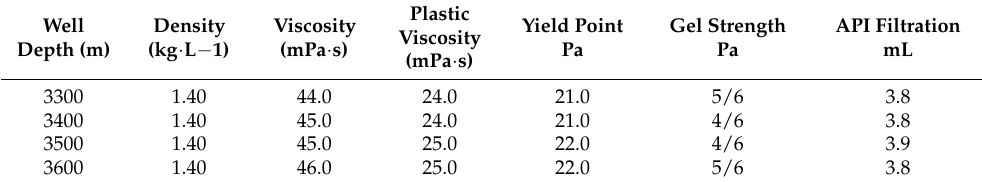
Table 11. Comparison of drilling fluid rheology at different